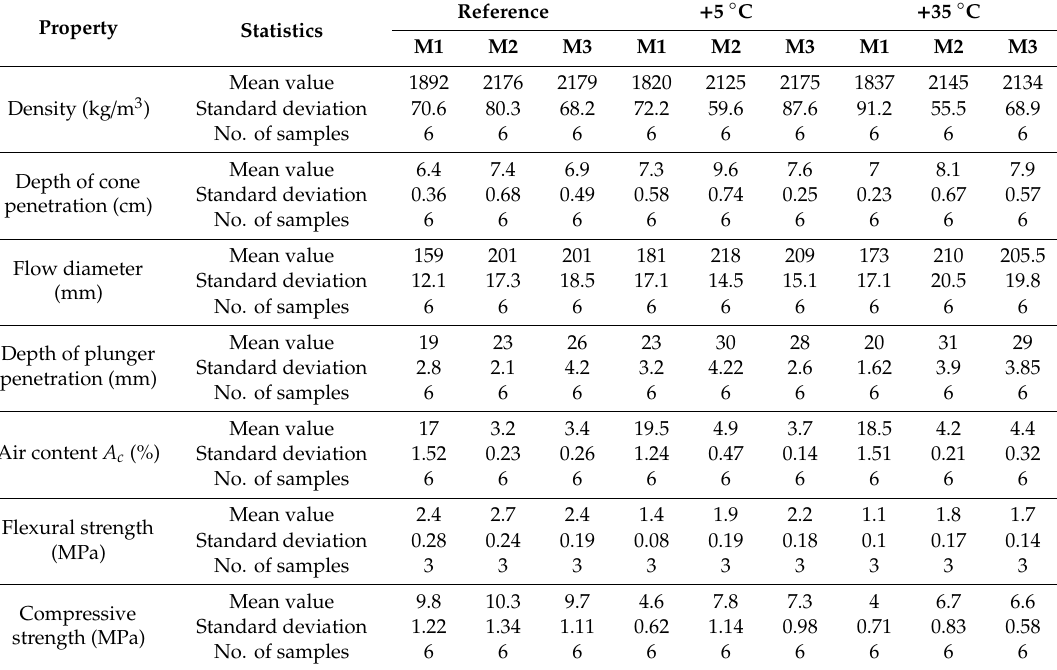
Table 22. Results of tests of the influence of temperature on properties of masonry mortars.